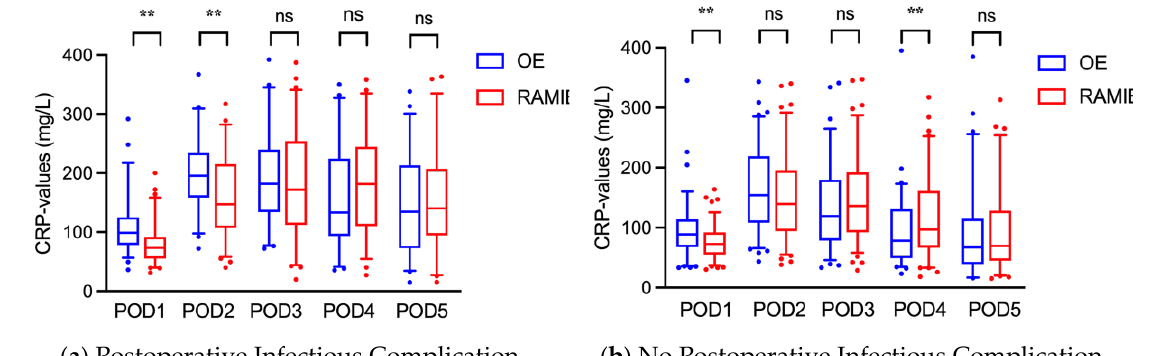
( b ) Open Procedure Figure 2. Postoperative CRP-values of patients undergoing RAMIE (n = 160) ( a ) or OE (n = 145) ( b ) stratified by development of PIC (NoPIC vs . PIC). CRP: C-reactive protein, PIC: postoperative in- fectious complications, POD: postoperative day, ns: no significance, *: p = 0.01, **: p ≤ 0.01. Within the PIC-group, CRP-values in RAMIE-patients were significantly lower at